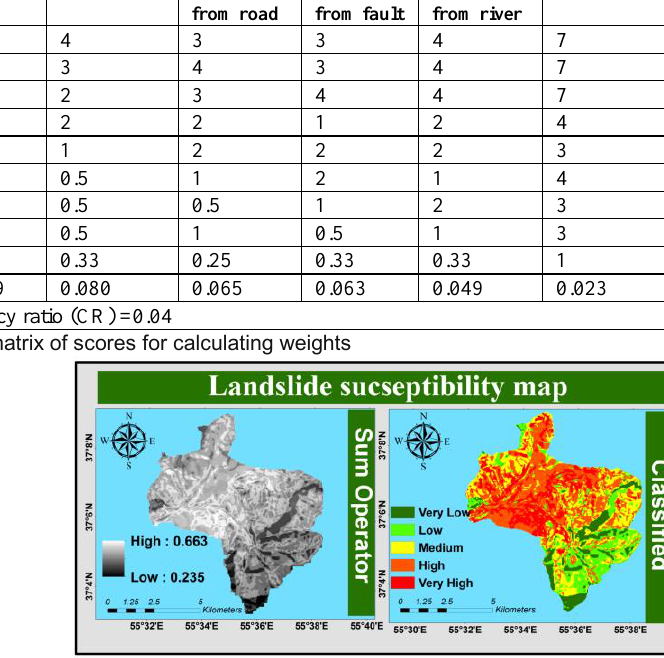
Figure 5. Landslide susceptibility maps